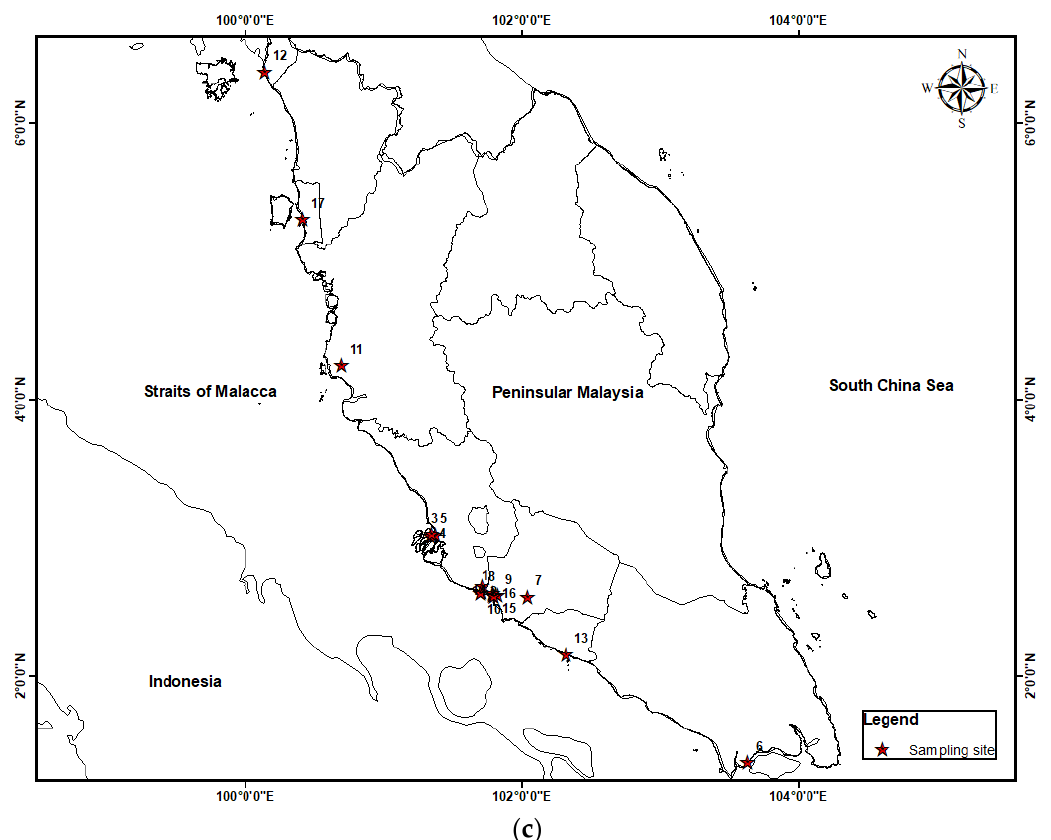
Figure 1. ( a ) Map of fishing loading sites at Kampong Fikri (1) and Kampung Rhu Sepuluh (2) in Setiu, Terengganu, Peninsular Malaysia. ( b ) Sampling map of Anadara granosa from 12 sampling sites from the intertidal waters of the west coast of Peninsular Malaysia. ( c ) Sampling map of Cerithidea obtusa from 17 sampling sites from the mangrove area of the west coast of Peninsular Malaysia.